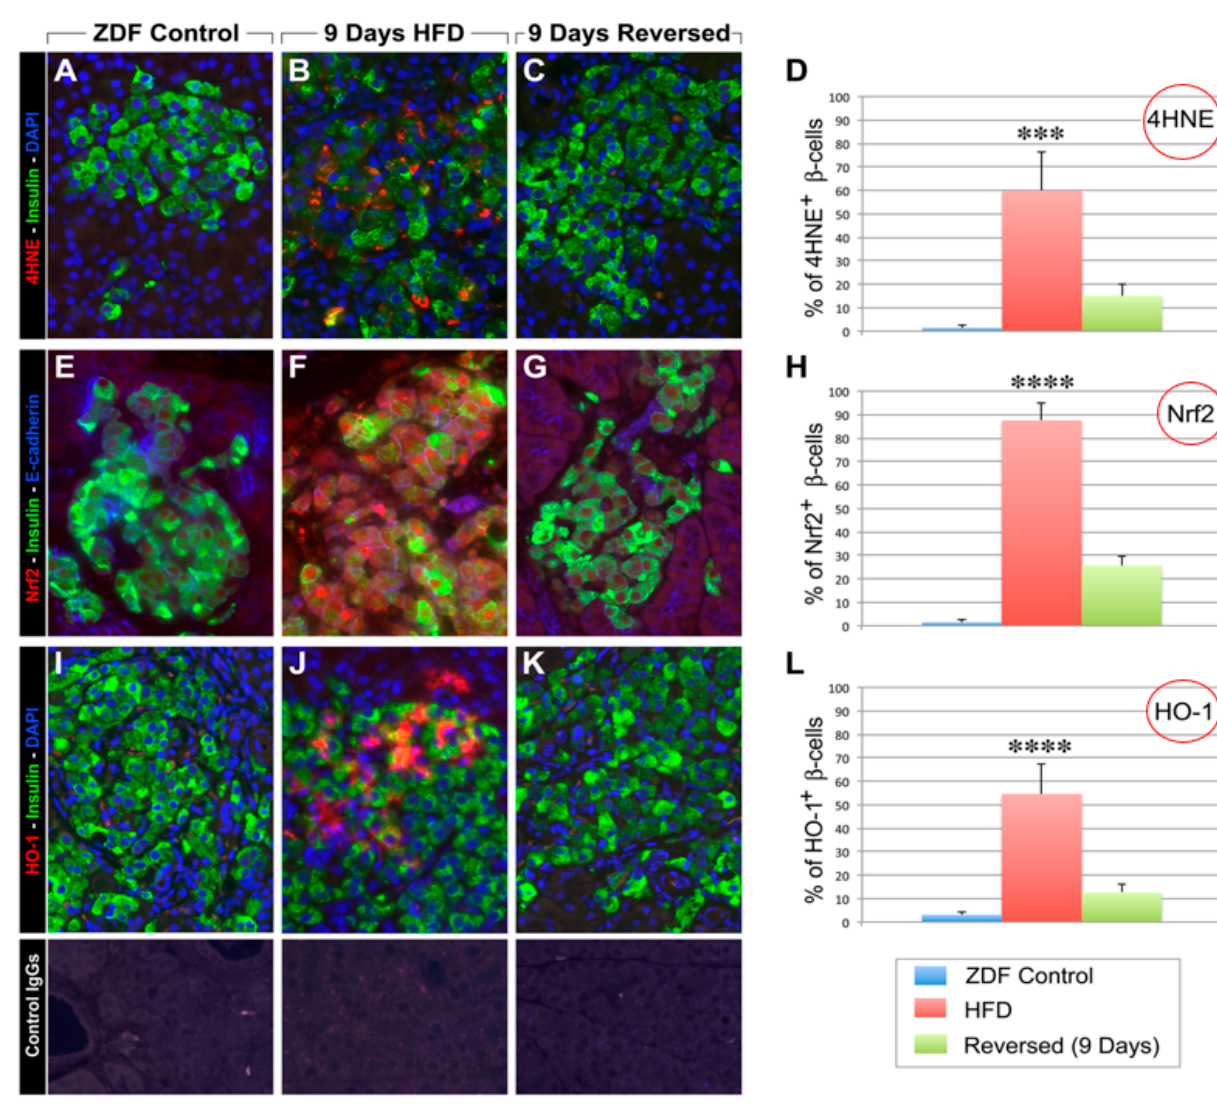
Figure 5. ( A ) Pancreatic sections were double labeled for insulin (green fluorescence) and 4-HNE (a marker for oxidative stress; red fluorescence). ZDF rats after 9 days of a high-fat diet showed intense cytoplasmic staining for 4-HNE in beta cells ( B ). This was reduced 2 weeks after a return to regular diets ( C ). Immunostaining for Nrf-2 (red fluorescence) revealed significant immunoreactivity both in the cytoplasm and the nucleus of beta cells ZDF rats fed high-fat diets for 9 days ( F ) when compared to ZDF controls ( E ). In contrast, 2 weeks after returning to regular diets the immunoreactivity for Nrf2 was dramatically reduced ( G ). Similarly, pancreatic sections stained for HO-1 (red fluorescence) showed increased cytoplasmic and nuclear localization of HO-1 ( J ) in beta cells (green fluorescence), which after 9 days of HFD was greatly diminished 2 weeks after return to regular diet ( K ). Specificity of detected immunoreactivities was validated by incubation of tissue sections with control IgGs from each species (lower panels). Morphometric analysis of markers of oxidative stress. To determine the presence of oxidative stress, pancreata from both control ZDF rats fed with a 17% fat diet and HFD-treated ZDF rats fed with a 48% fat diet were fixed overnight with 4% formalin. Fixed tissues were processed for paraffin embedding, and 4- μ m sections were prepared and mounted on slides. Sections from both groups of animals were chosen at 25- μ m intervals for immunolocalization of 4HNE, Nrf2, and HO-1, as well as insulin to identify β cells and E-cadherin to identify the pan- creatic epithelium. Fifty sections per animal group were analyzed for morphometric measurements. Primary antibodies used for these experiments included anti-4HNE (Abcam, ab46545), anti-Nrf2 (Abcam, ab31163), and anti–HO-1 (Enzo Life Sciences), all used at 1:100 dilution and incubated overnight at 4 °C. Following reaction with fluorophore-conjugated secondary antibodies (Jackson